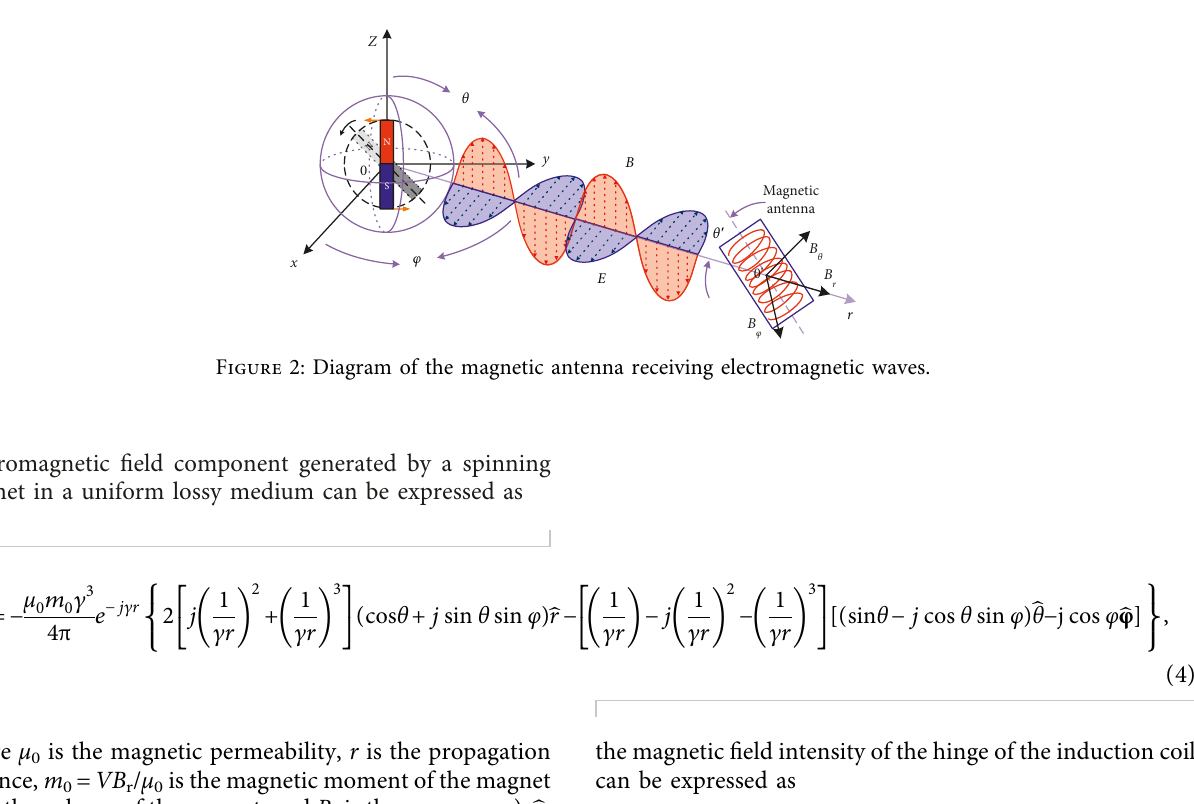
Figure 1: System model and energy conversion of RMBMA.